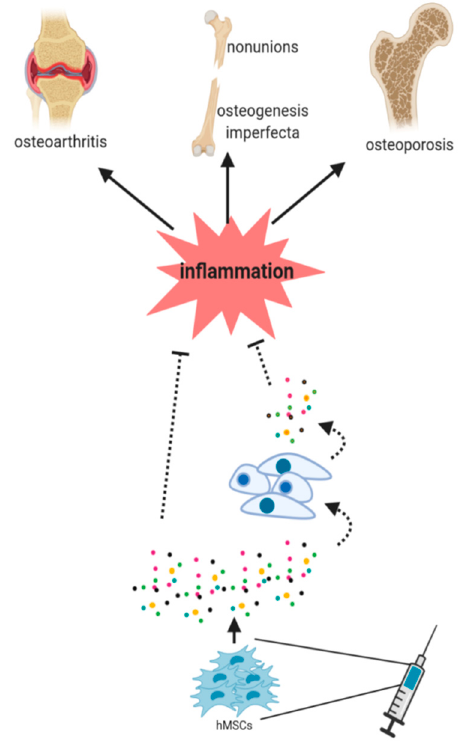
Figure 2. hMSCs should face an inflammatory microenvironment to exert their benefits in cell therapy purposes. The paracrine signaling of hMSCs has been postulated to be an essential mechanism in this healing process. The secretion of factors by MSCs (paracrine signaling) seems to be essential in this process. However, it is still unknown (dash lines) whether the secreted factors directly induce the healing or if they induce different signaling pathways in the host cells, thus stimulating then tissue regeneration.